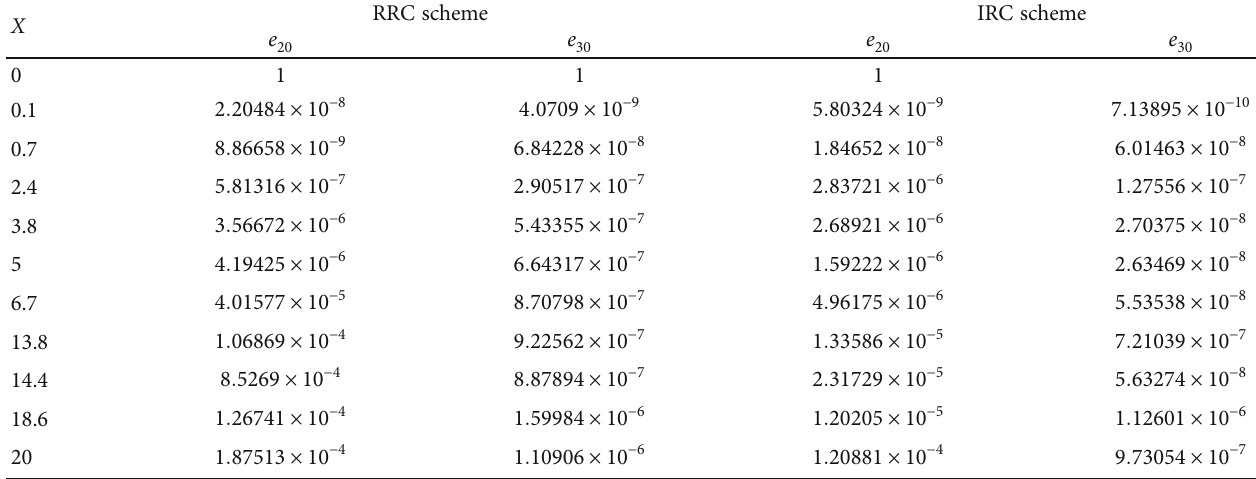
Table 7: Comparison between absolute errors given by two proposed schemes.